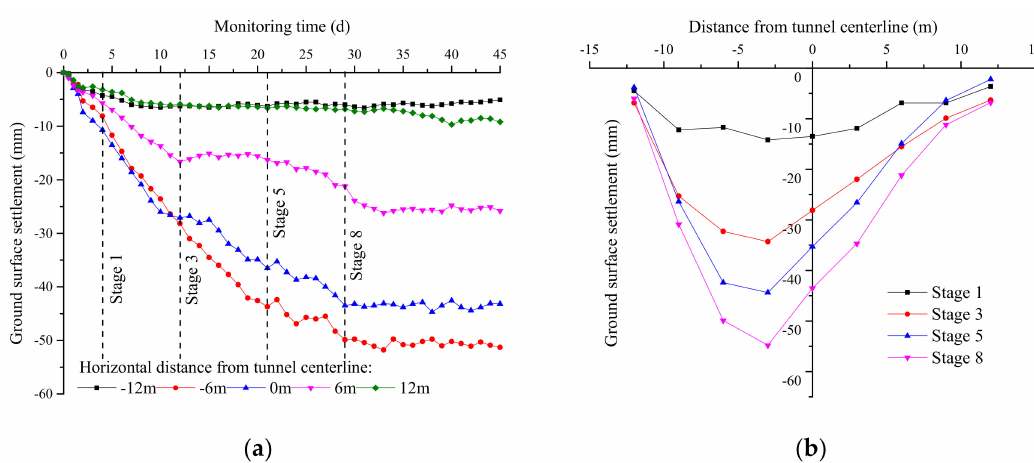
Figure 12. Surface settlements monitoring results of section DK70 + 829: ( a ) Development of GSSs; ( b ) Surface settlement troughs of typical excavation stages.